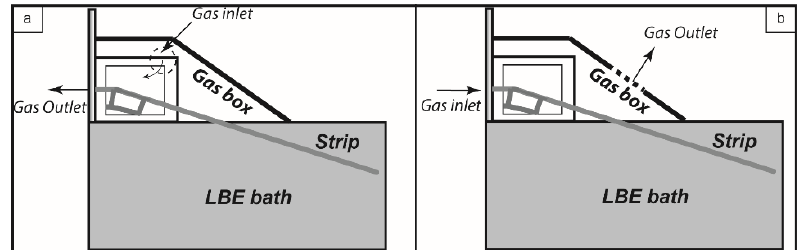
Figure 10. Schematic view of different positions of the gas inlet and outlet. ( a ) Gas inlet from side of the gas box [16] ( b ) An alternative location of the gas inlet focused in the current study.